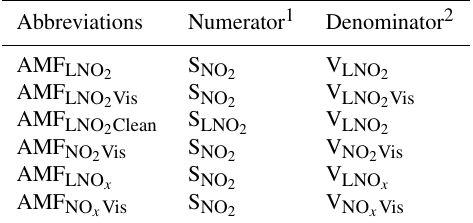
Table A1. Simple forms of abbreviations for